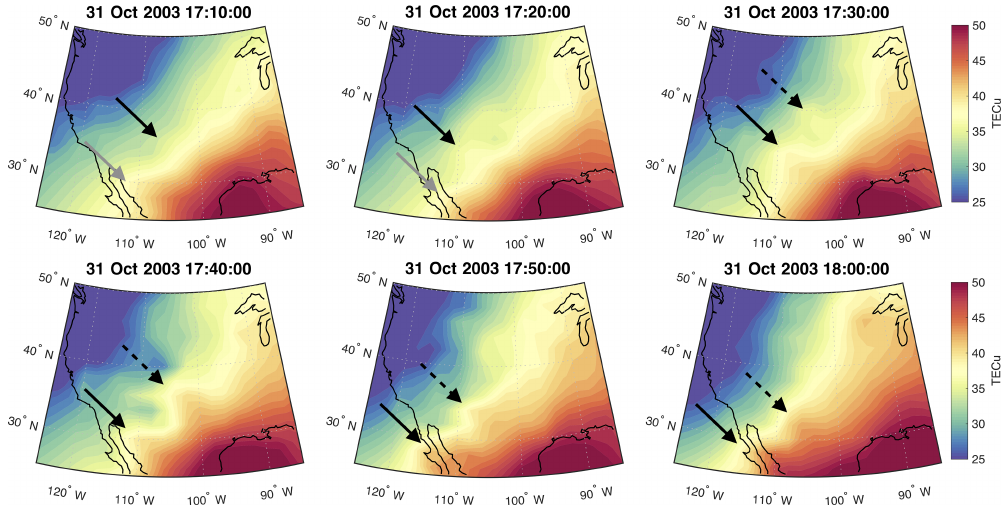
Figure 4. Series of vTEC from the MIDAS GPS inversion. Each frame is separated by 10min. Arrows have been added to indicate identified wave crests.